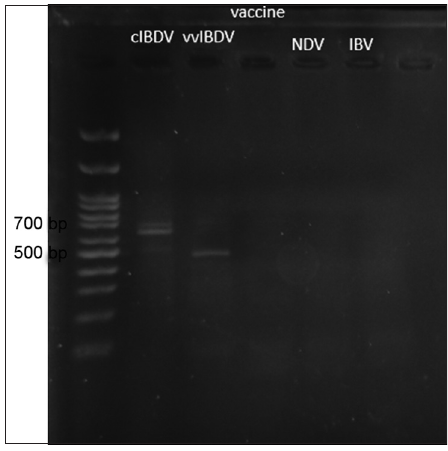
Figure-1: Result of multiplex reverse transcription- polymerase chain reaction showed a specific band of classic infectious bursal disease virus (BDV) at 700 base pairs and a specific band of very virulent infectious BDV at 500 base pairs. There was no specific band in other viruses.